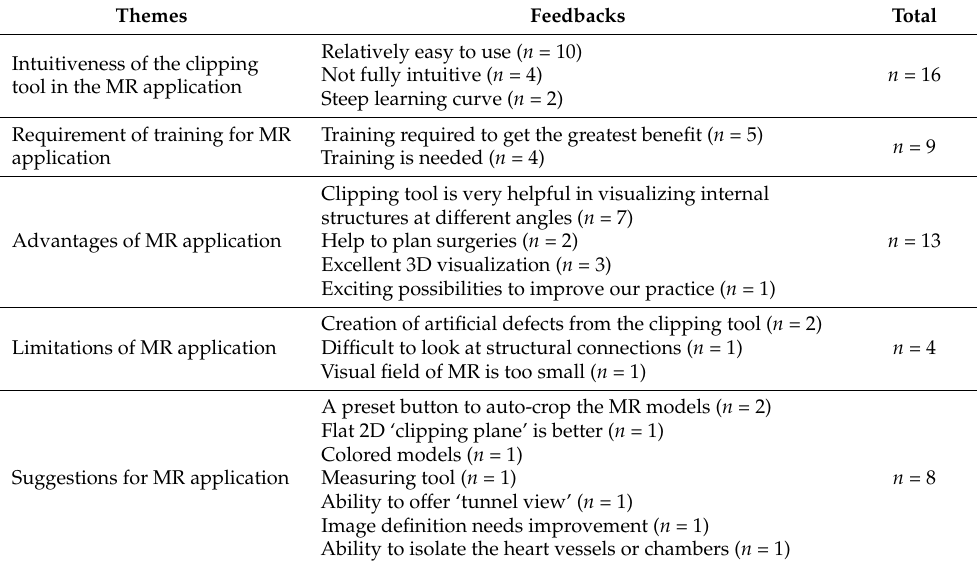
Table 5. Thematic analysis of qualitative